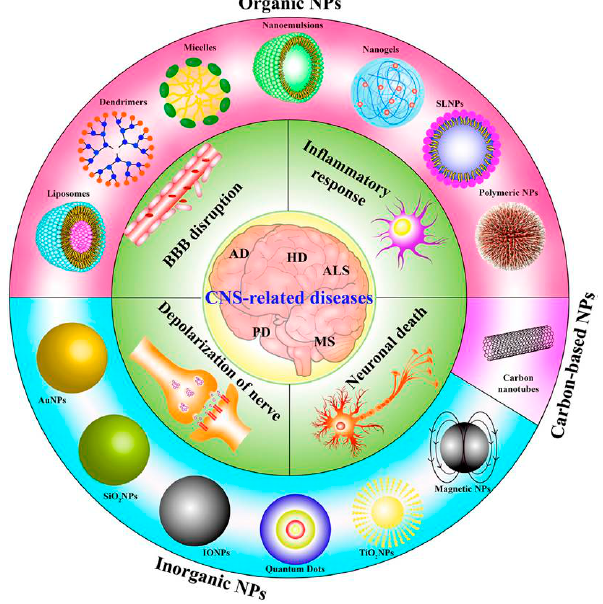
Figure 6. The potential therapeutic effects of NPs on the inflammatory response, neuronal death, depolarization of the nerve, and BBB disruption in CNS diseases including AD, PD, HD, ALS, and MS. Reproduced from [72].